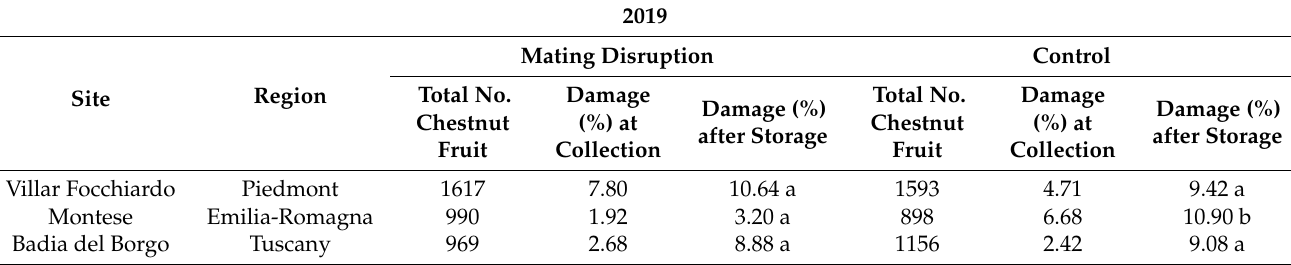
Table 1. Total number of chestnut fruits collected per site and region in MD and control plots, and percentage of damage recorded at collection and after storage in the two-year period 2019–2020. The mean proportions followed by different letters in a row are significantly different (Tukey’s test, p < 0.05). Damage refers to any emergence hole with a typical diameter attributable to Cydia spp.